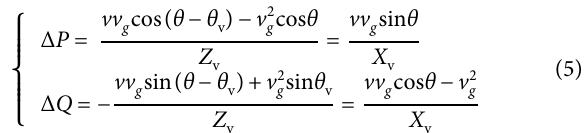
respectively. U , P and Q are voltage, active power and ref ref ref reactive power reference values in droop control